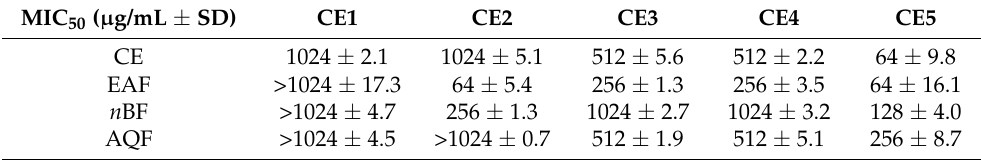
Table 1. The MIC 50 of Monteverdia ilicifolia extracts and fractions against Helicobacter pylori . MIC 50 ( µ g/mL ±